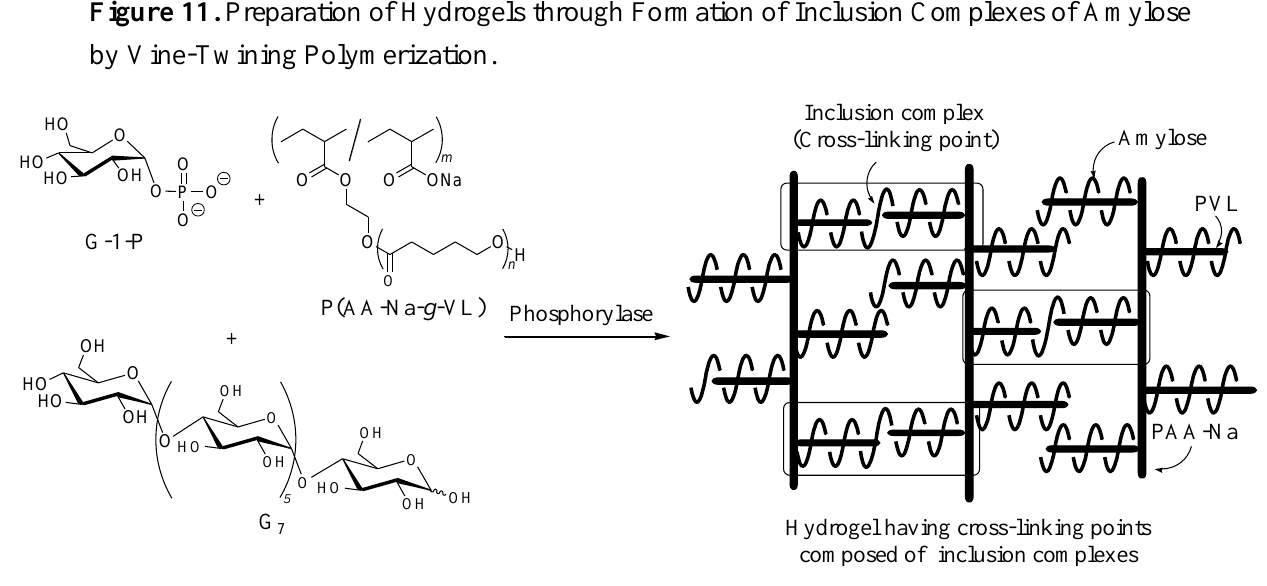
Figure 12. Cycle of enzymatic disruption and reproduction of hydrogel by two enzymatic